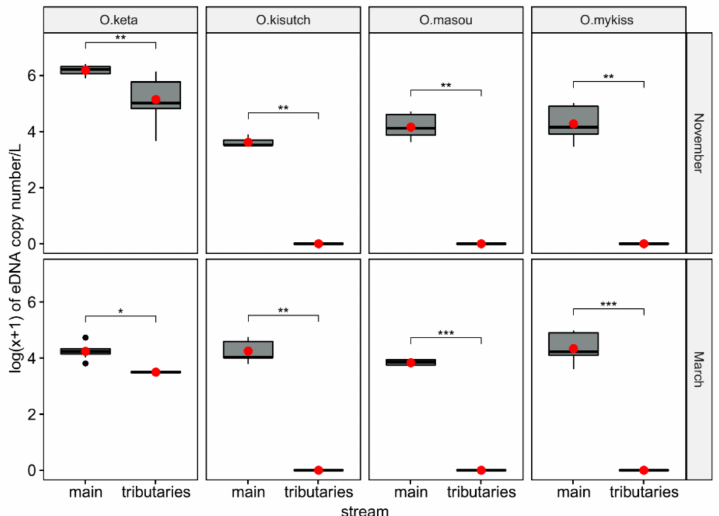
Figure 7. Log(x + 1) transformation of the inhibition-normalized eDNA copy number of the four species of Oncorhynchus in the Yangyangnamdae River compared between the main stream and tributaries using whiskers plots. Means and medians are presented as red circles and horizontal solid lines within each box, respectively. Asterisks indicate the significance level ( p ) for each comparison by pairwise Wilcoxon rank-sum tests: * p < 0.05; ** p < 0.01; *** p <